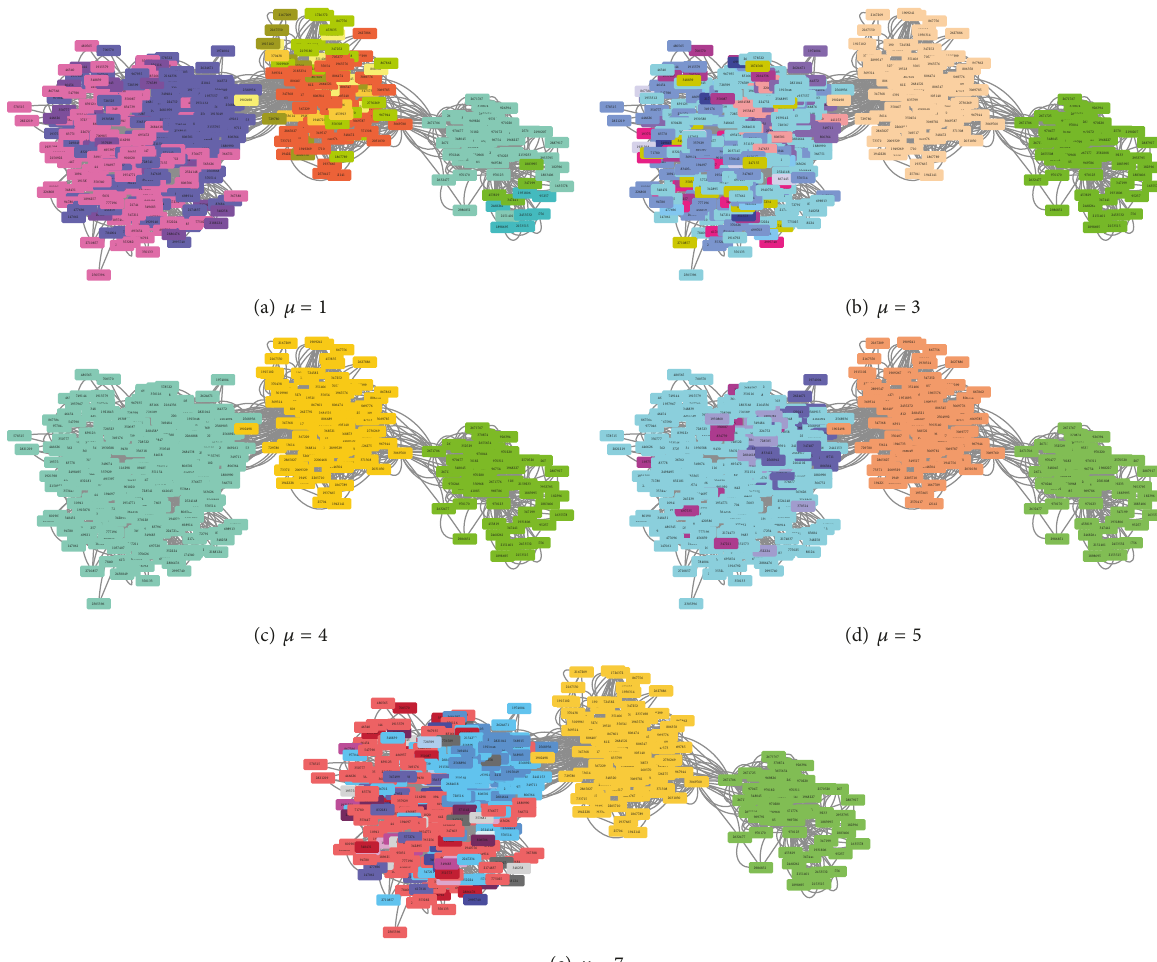
Figure 2: Varying the results of the density parameter 𝜇 to obtain the optimal